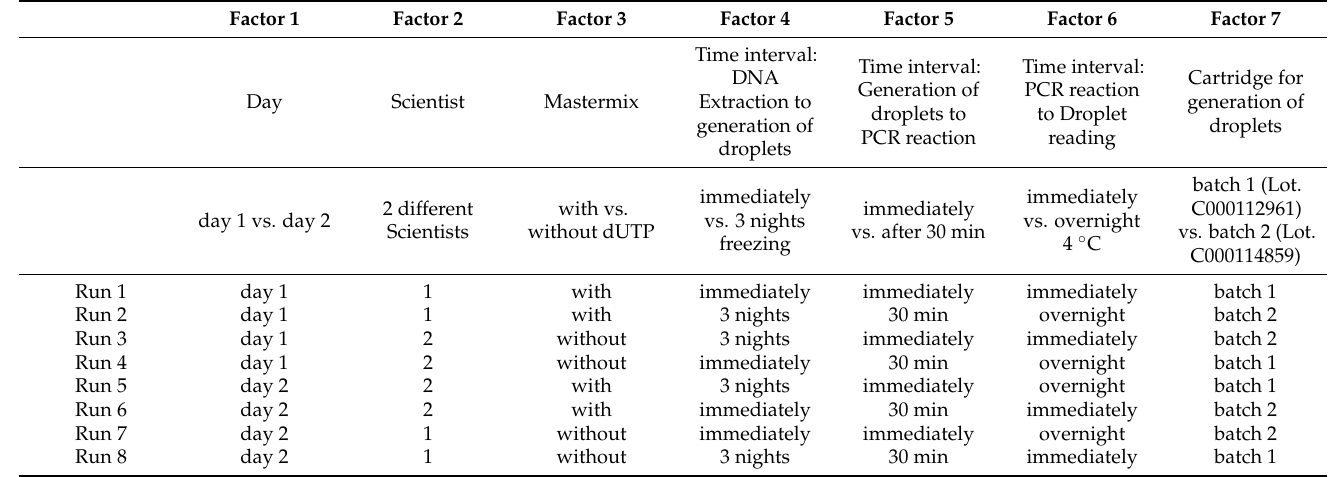
Table 4. Factorial design for the evaluation of technical uncertainty (7 factors).